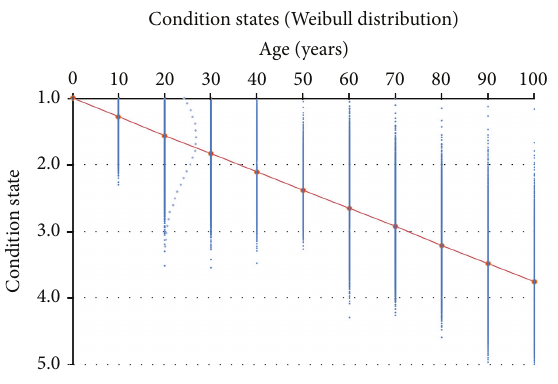
Figure 9: Synthetic condition state